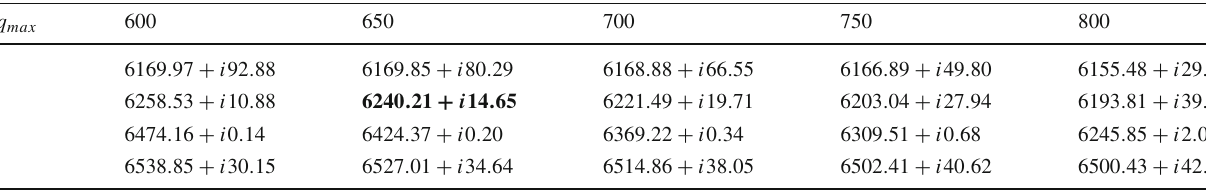
Table 23 The poles in the J P = 3 / 2 − sector from the pseudoscalar-baron interaction (all units are in MeV) q max